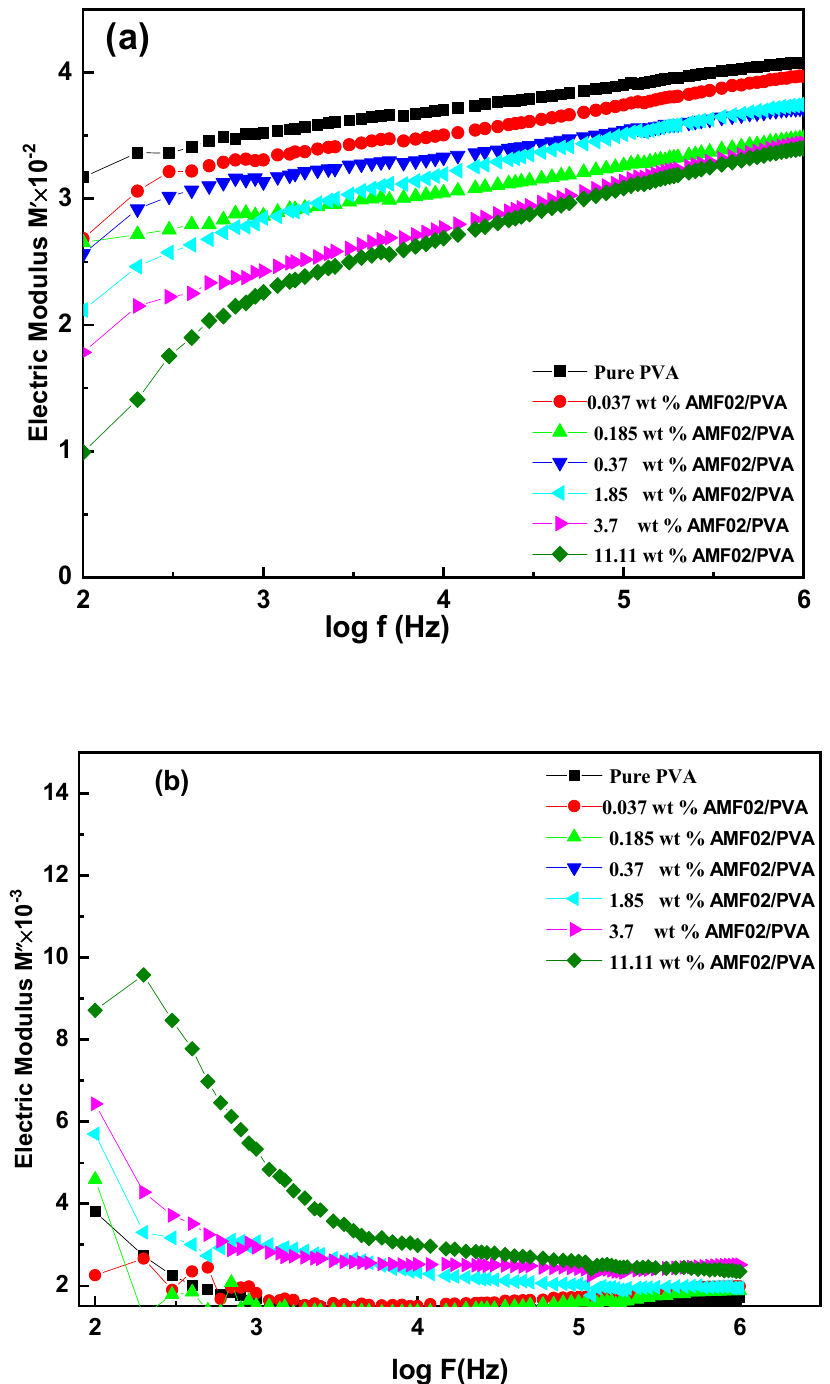
Figure 11. ( a ) Real and ( b ) imaginary parts of electrical modules against frequency for all novel PCCEFs.